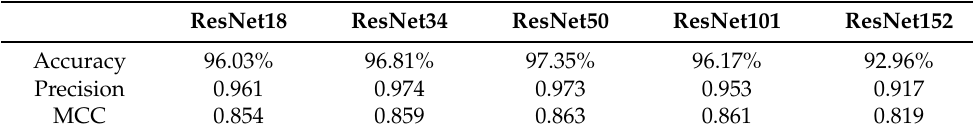
Table 3. Performance comparison of ResNet series models.